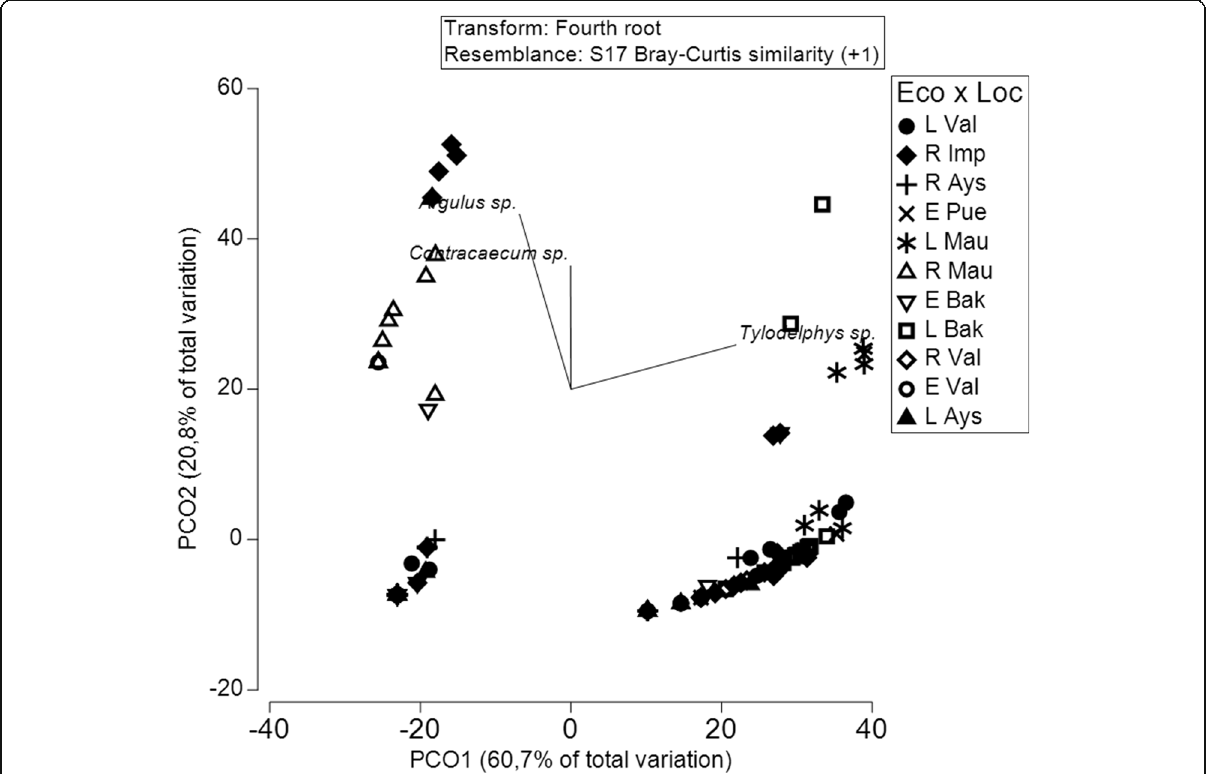
Fig. 2 Principal Coordinates Analysis (PCo) of the composition of parasite infracommunities in G. maculatus according to sampling locations and ecosystems. Vectors indicate species that had Spearman ’ s rank correlations >